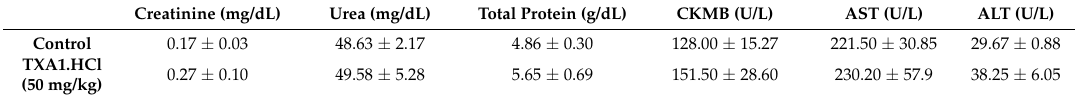
Table 1. Blood biochemical analyses of treated and control